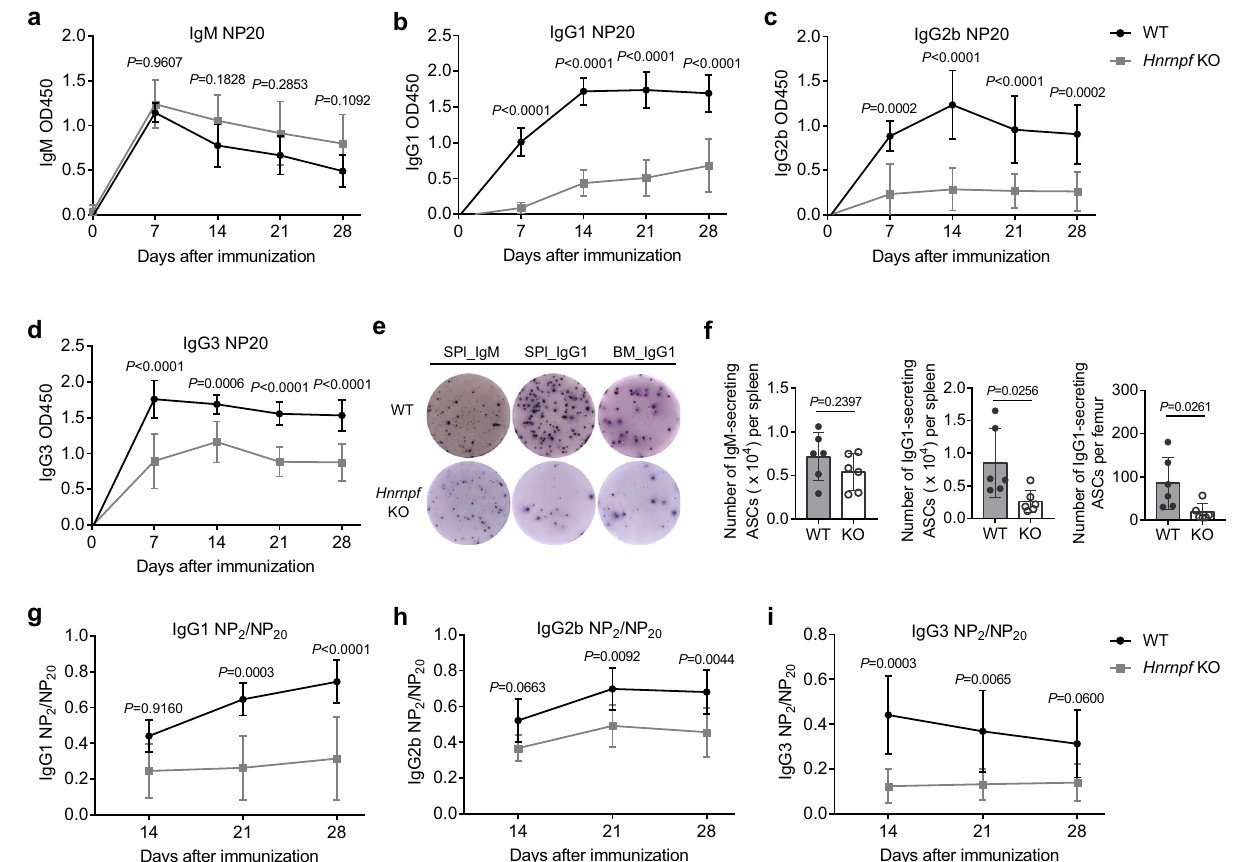
Fig. 2 | hnRNPF is required for TD antibody immune response. a – d ELISA of determining antibody titers of NP-speci fi c IgM ( a ), IgG1( b ),IgG2b ( c ),and IgG3 ( d ) in the serum of WT and Hnrnpf KO mice at various time points post-immunization ( n =6for WTgroup and n =7for Hnrnpf KO group). e ELISPOTassayof NP-speci fi c IgM and IgG1 antibody-secreting cells in the spleen and BM of WT and Hnrnpf KO mice at day 10 post-immunization ( n =6 per group). f Enumeration of antibody- secreting cells inthe spleen andBMasdetermined in e . Eachsymbolrepresents an individualmouseanalyzed. g – i RatiosofNP-speci fi cIgG1( g ),IgG2b( h ),andIgG3( i )